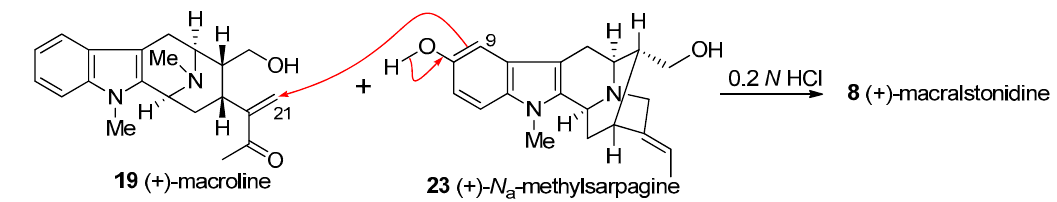
Scheme 15. Synthesis of (+)- 8 by condensing (+)-macroline ( 19 ) and (+)- N a -methylsarpagine ( 23 ) under acidic conditions.